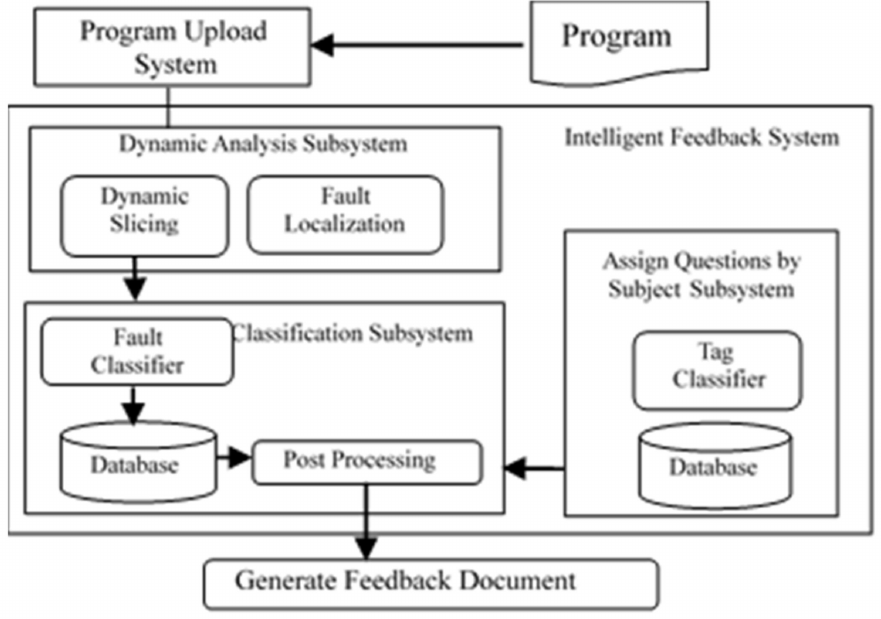
Figure 5. Monitoring model